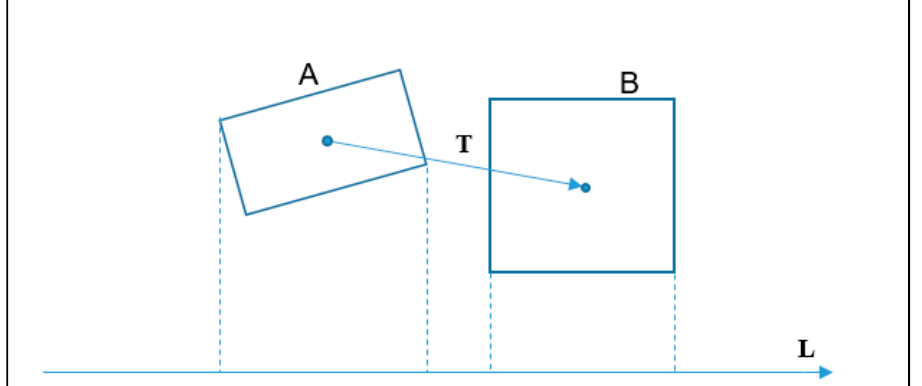
Figure 5. Separating Axis Theorem in 2D space.